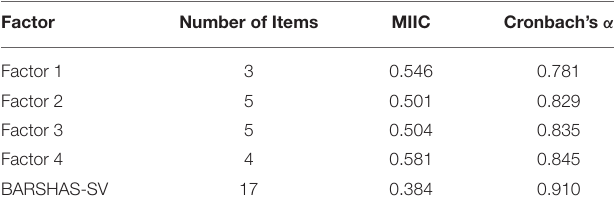
TABLE 6 | The Cronbach’s α coefficients and the MIIC values and of four factors and the whole BARSHAS-SV.